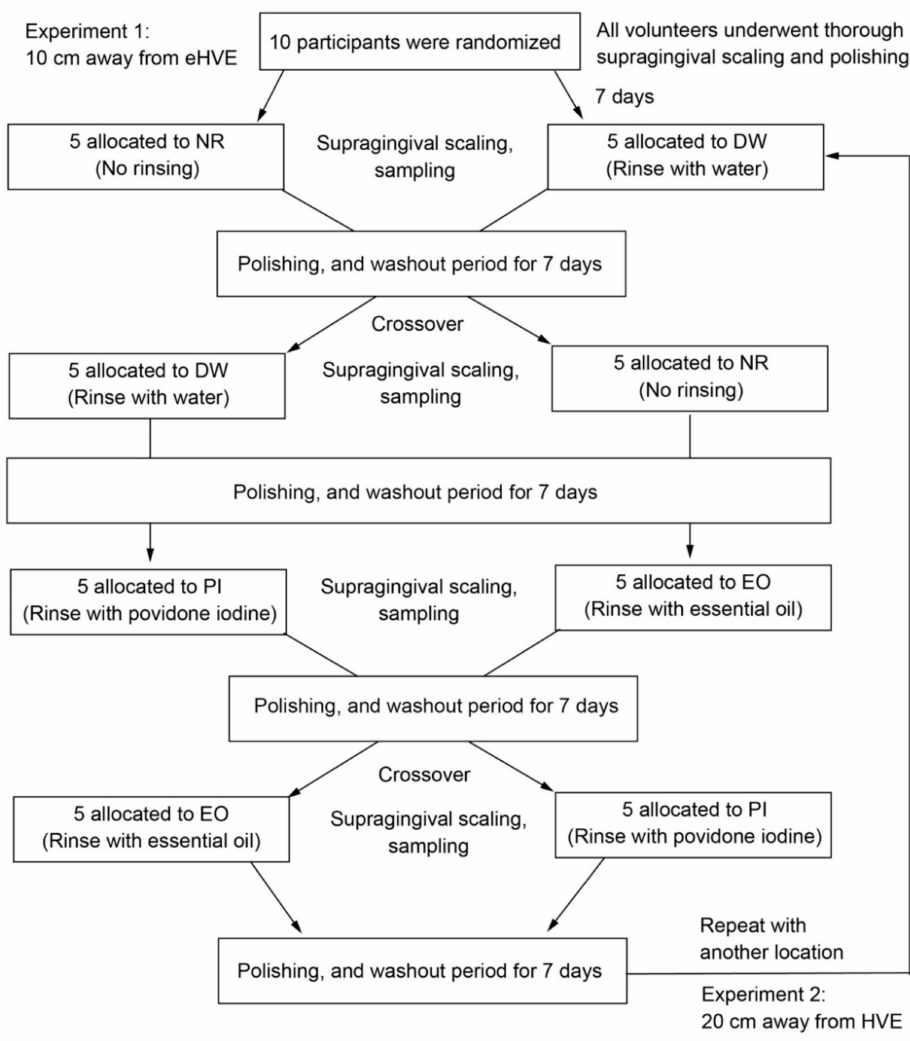
Figure 1. Flow chart of study